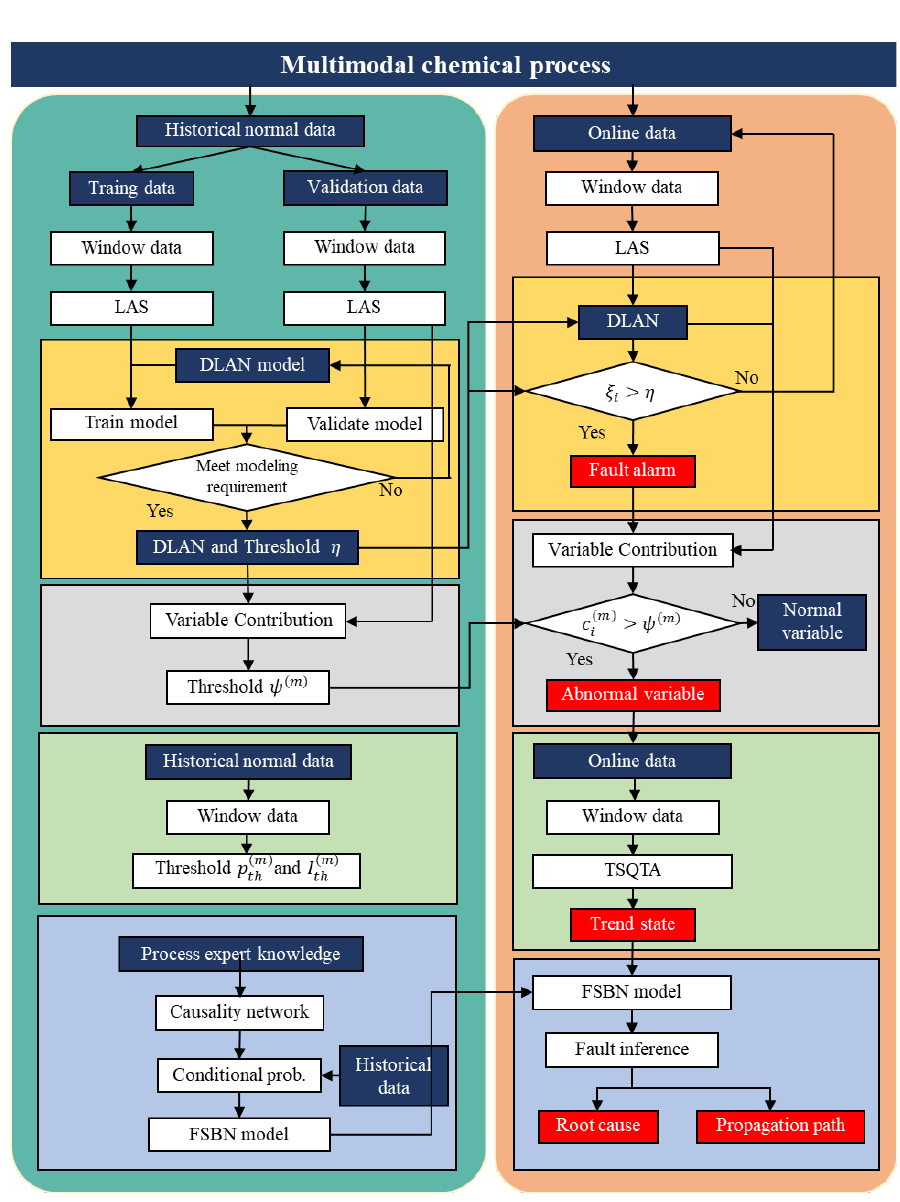
Figure 6. The three-step framework for multimodal industrial process monitoring. Offline modeling